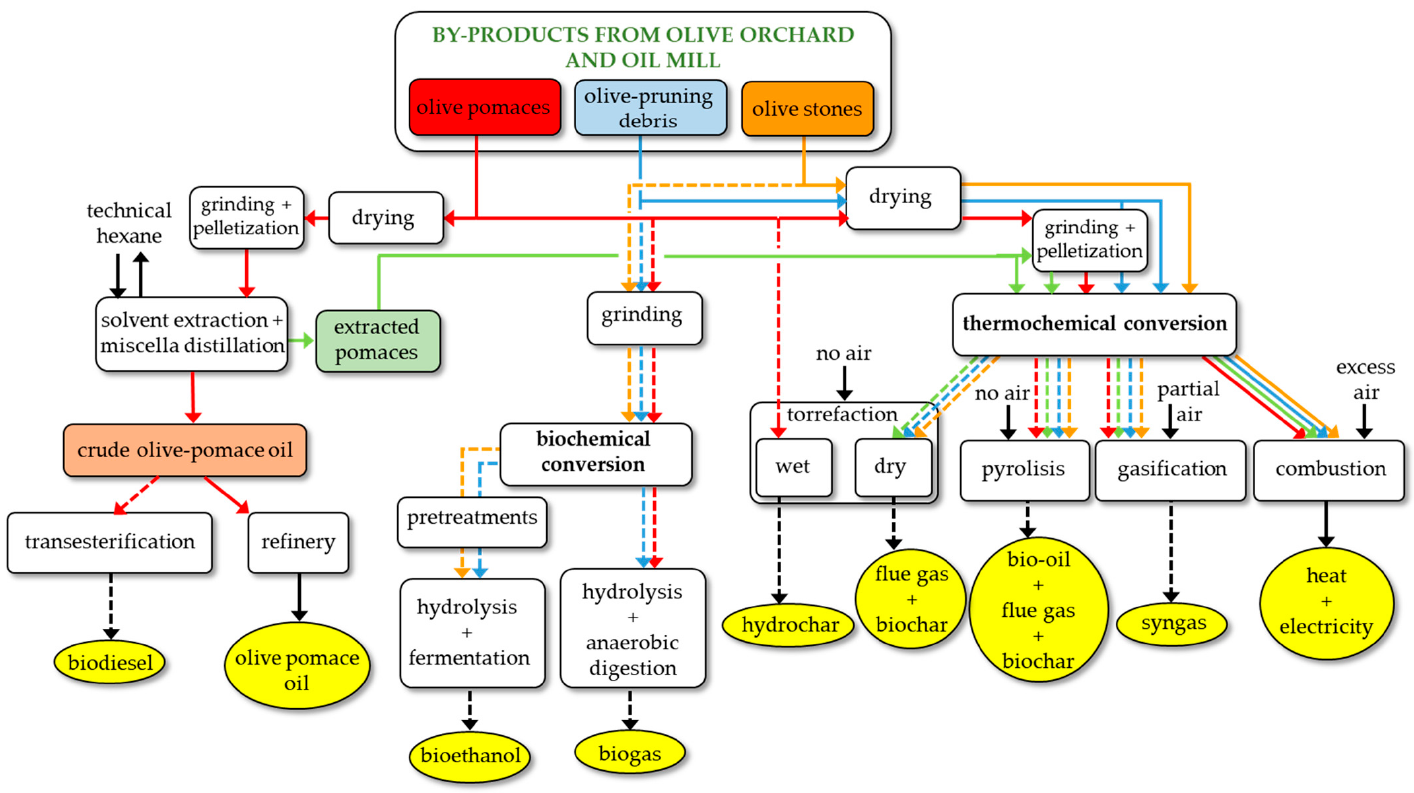
Figure 8. Valorisation routes of olive mills by-products towards energy. Solid lines stand for actual industry processes while dashed lines represent potential applications at research